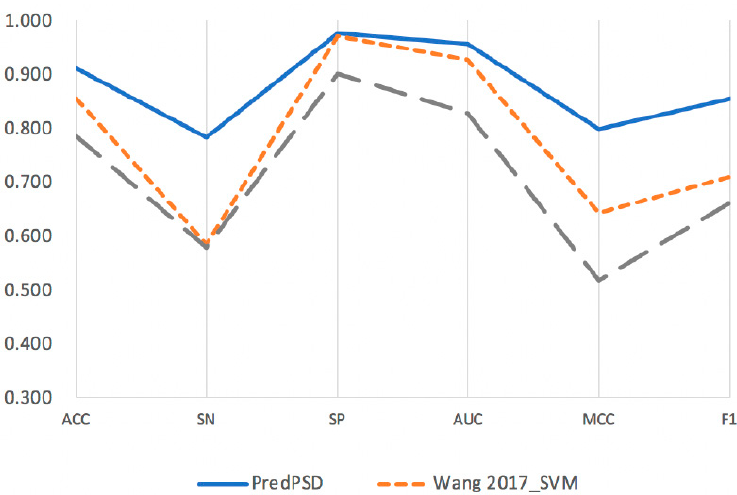
Figure 7. Performance comparison between our method and three existing classification methods on SSBs and DSBs from our training set. The existing classification methods are Wang 2017_SVM (based on sequence information and an SVM algorithm) and Wang 2017_RF (based on sequence information and an RF algorithm), all proposed by Wang W. et al. To our knowledge only these two methods are all relevant to this study.